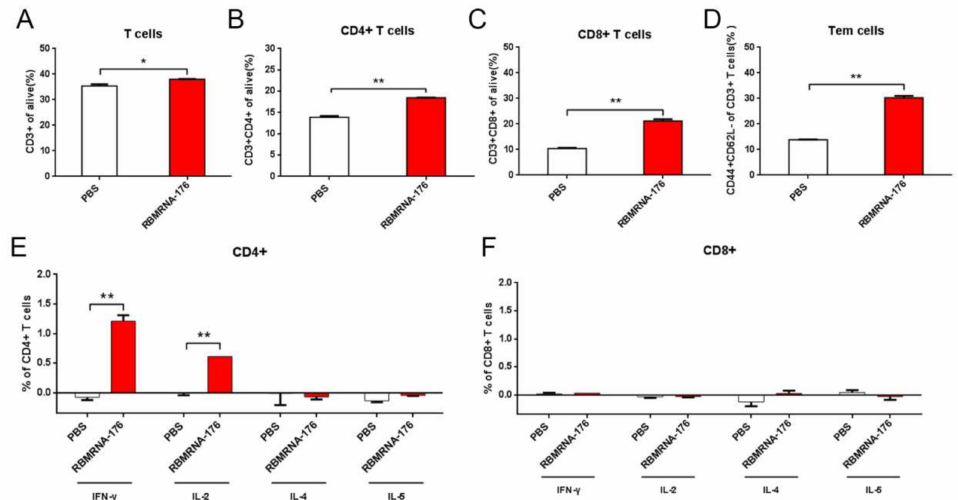
Figure 4. Assessment of RBMRNA-176-induced T cell responses and effects on proliferation of immune cell populations in the spleen. BALB/c mice were vaccinated with two shots of 20 µ g RBMRNA-176 at an interval of 21 days. 7 days post-boost, splenocytes were isolated from 3 mice per group, and lymphocyte subset percentages (CD3+, CD4+, CD8+ and Tem) were measured ( A – D ). Splenocytes were re-stimulated with 1 µ g SARS-CoV-2 Spike trimer protein. After 6 h, CD4+ T cells ( E ) or CD8+ T cells ( F ) expressing IFN- γ , IL-2, IL-4, and IL-5 in response to the S Protein were detected by intracellular cytokine staining (ICS). * p < 0.05, ** p <